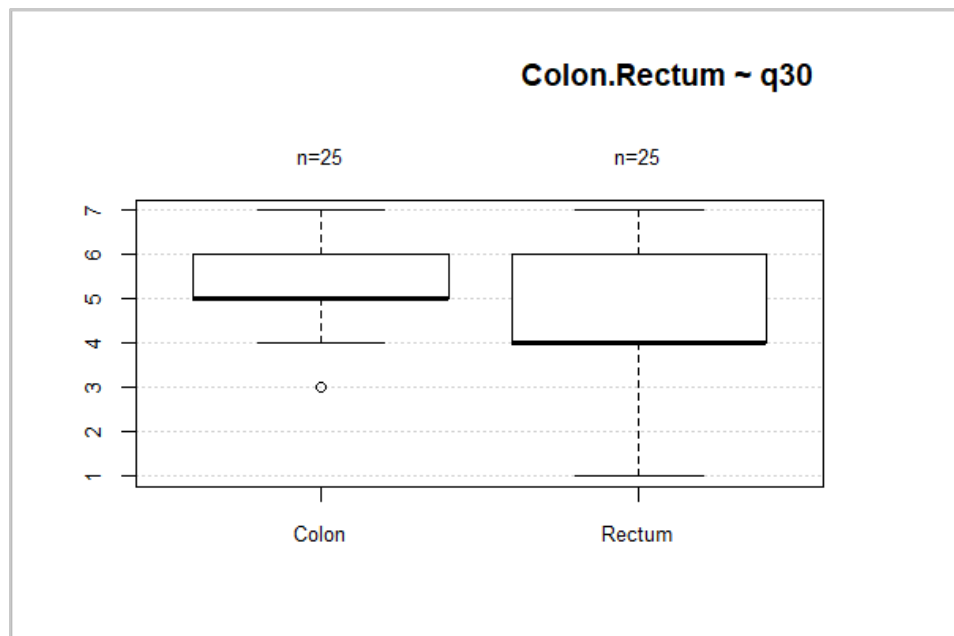
Figure 9. Tumor localization and overall QoL.